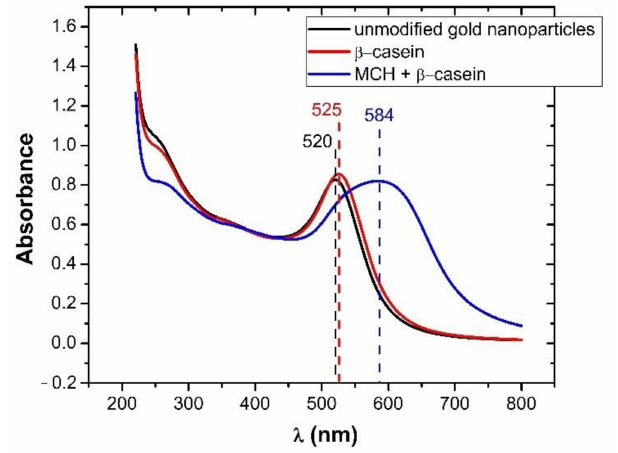
Figure 3. Absorption spectra for AuNPs prepared by the Turkevich method: unmodified (black), modified by β -casein (red) and further modified by MCH (blue)